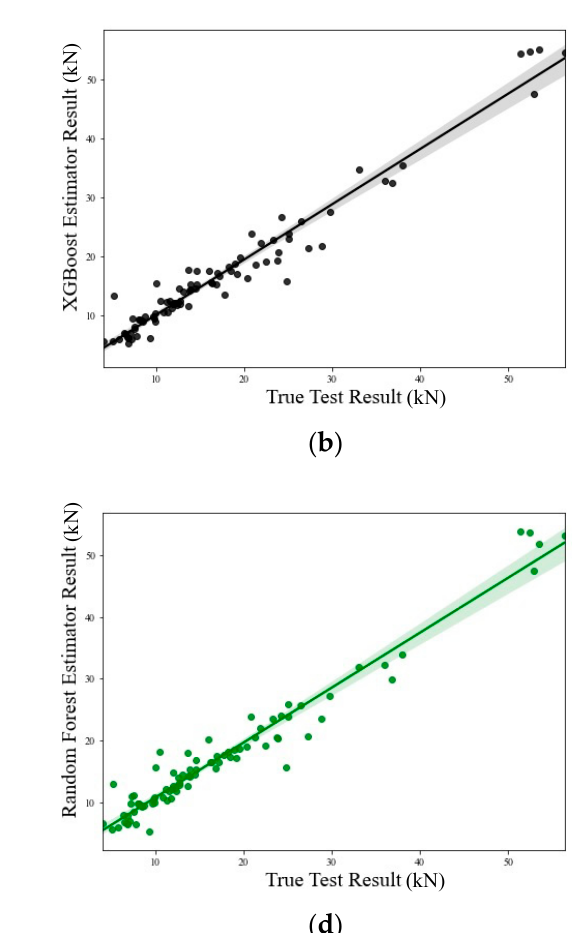
Figure 5. Actual vs. predicted result of the ensemble methods. ( a ) CatBoost, ( b ) XGBoost, ( c ) HGBoost, and ( d ) random forest.